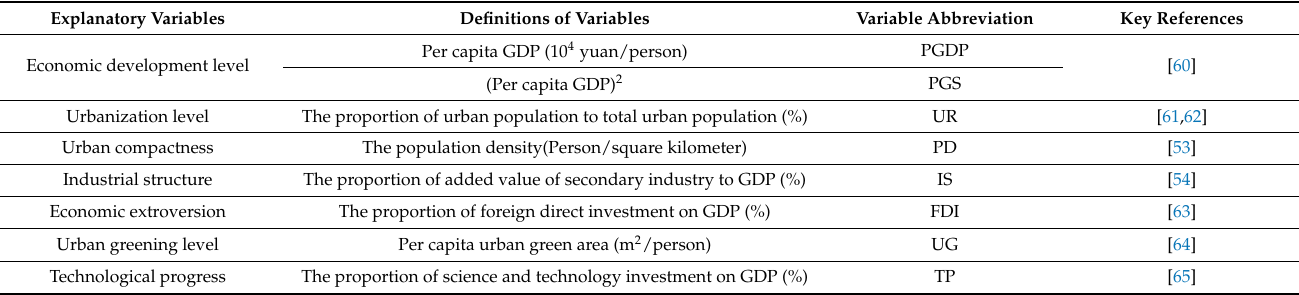
Table 2. The definition of